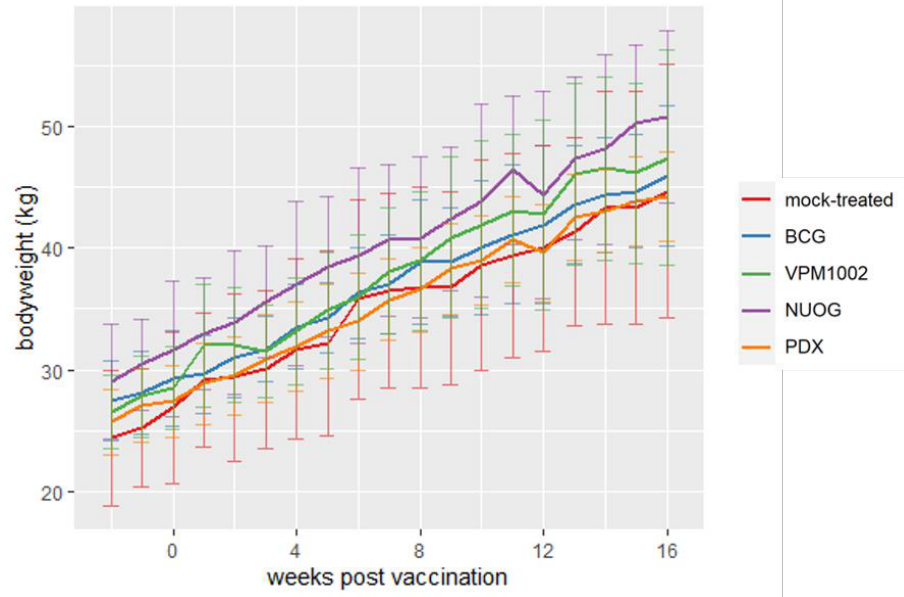
Figure 2. Changes in body weight of goats vaccinated with different vaccine strains (BCG, VPM1002, NUOG, PDX) and a mock-treated control group. Depicted is the mean body weight (line plots) and standard deviation (vertical error bars) per